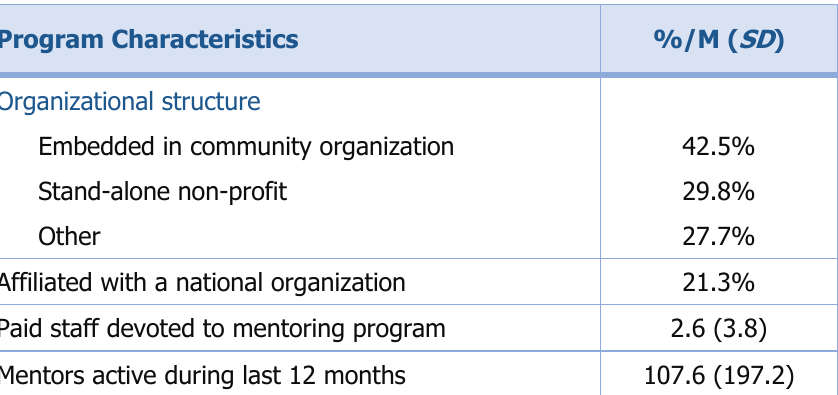
Table 1. Characteristics of Mentoring Programs (N =